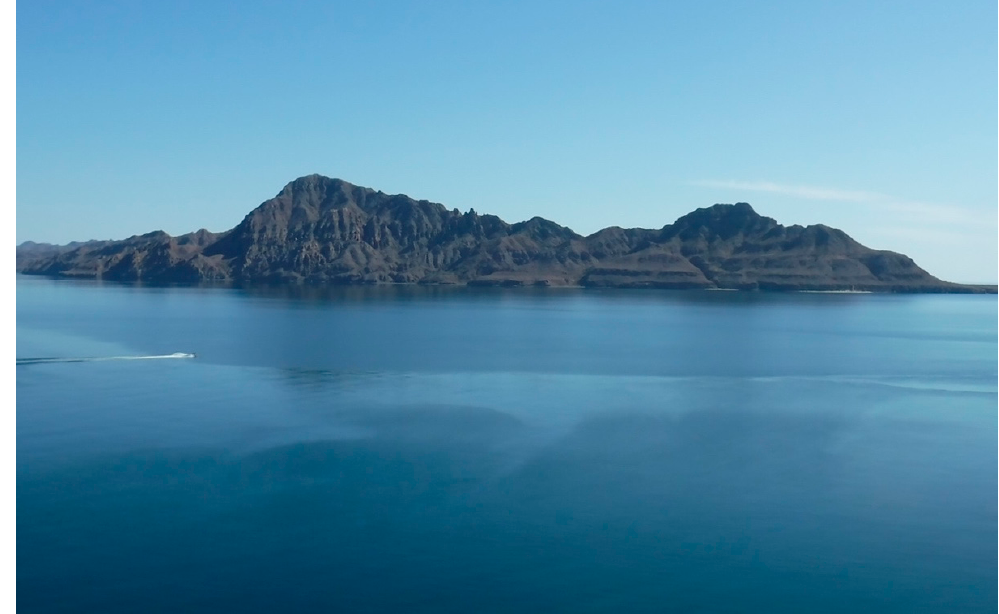
Figure 12. View east from Puerto Escondido across the Carmen Passage showing distinct marine terraces cut in the southwest side of Isla del Carmen. Motor boat and wake for scale at left, center.